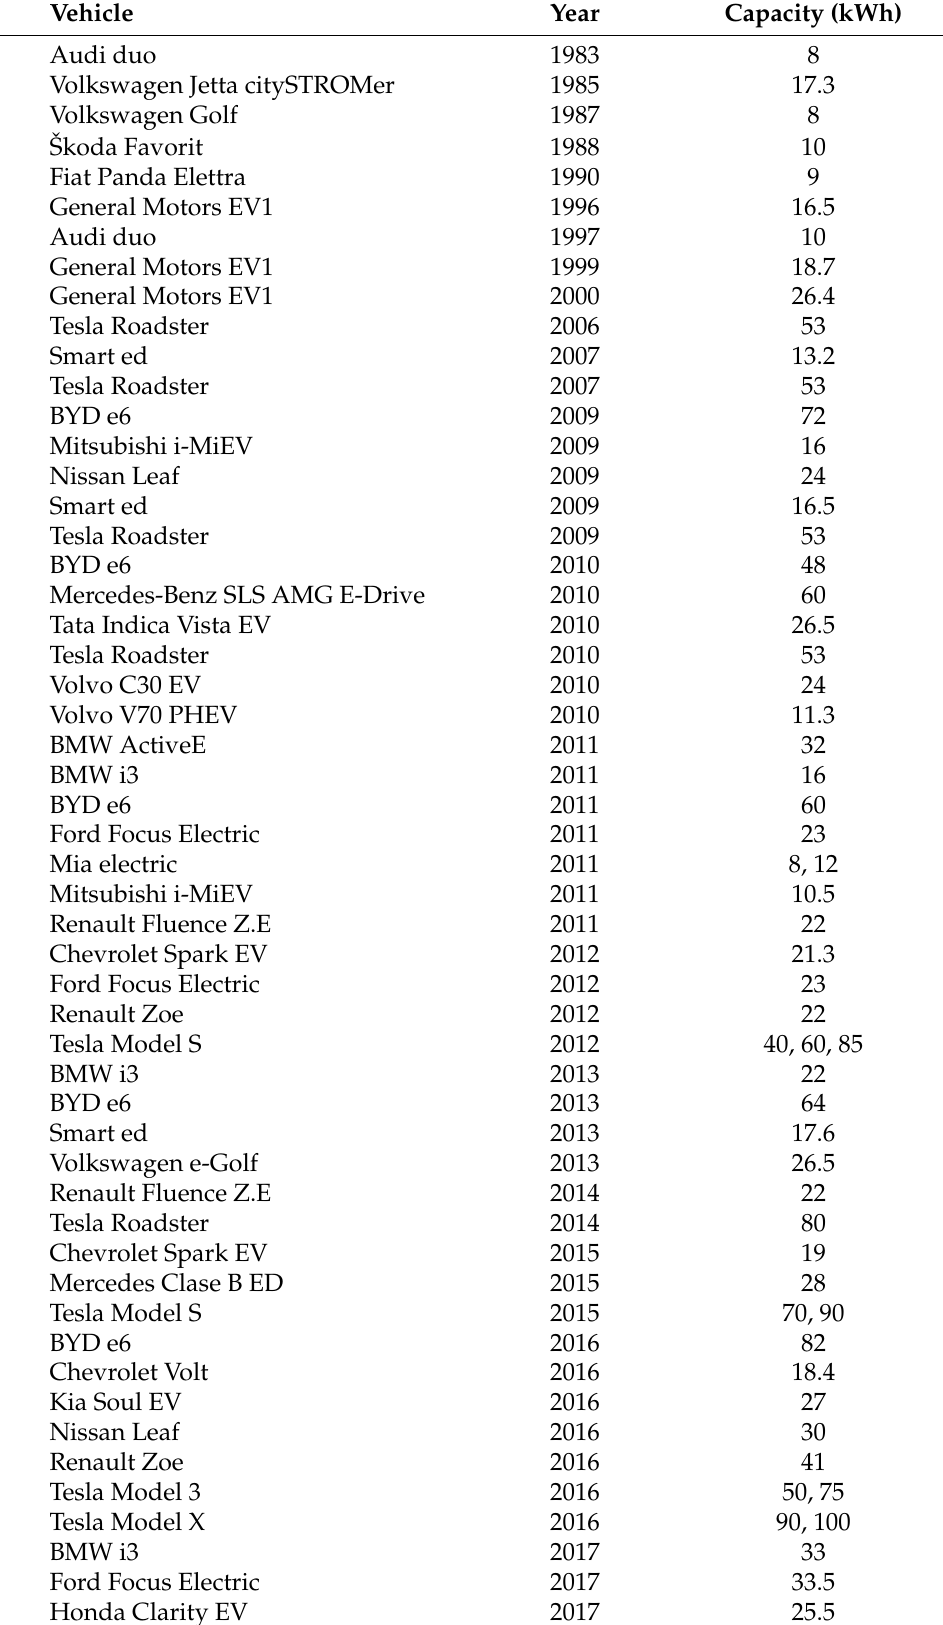
Table 2. Battery capacities of different electric vehicles